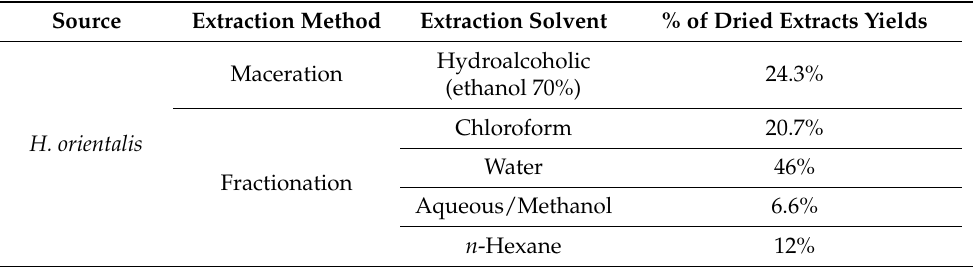
Table 1. The percentage yield obtained from the extraction of 2000 gm of H. orientalis using maceration and solvent fractionation methods (% yield = weight after extraction/weight before extraction *